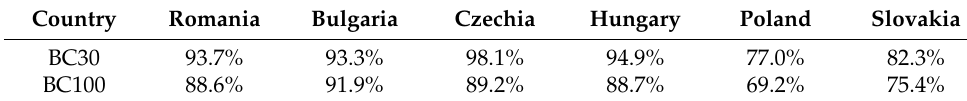
Table 2. Fixed broadband networks coverage by speed in 2021.